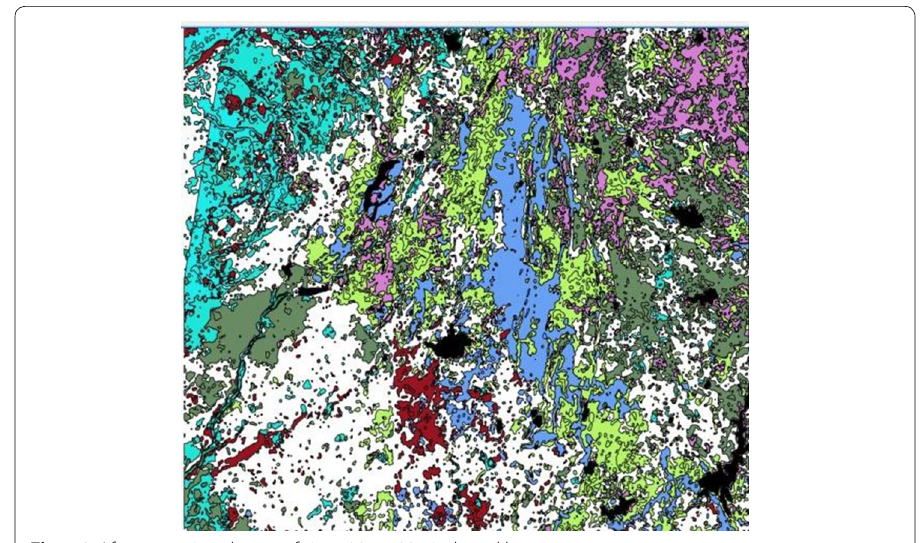
Fig. 16 After removing shapes of size 100